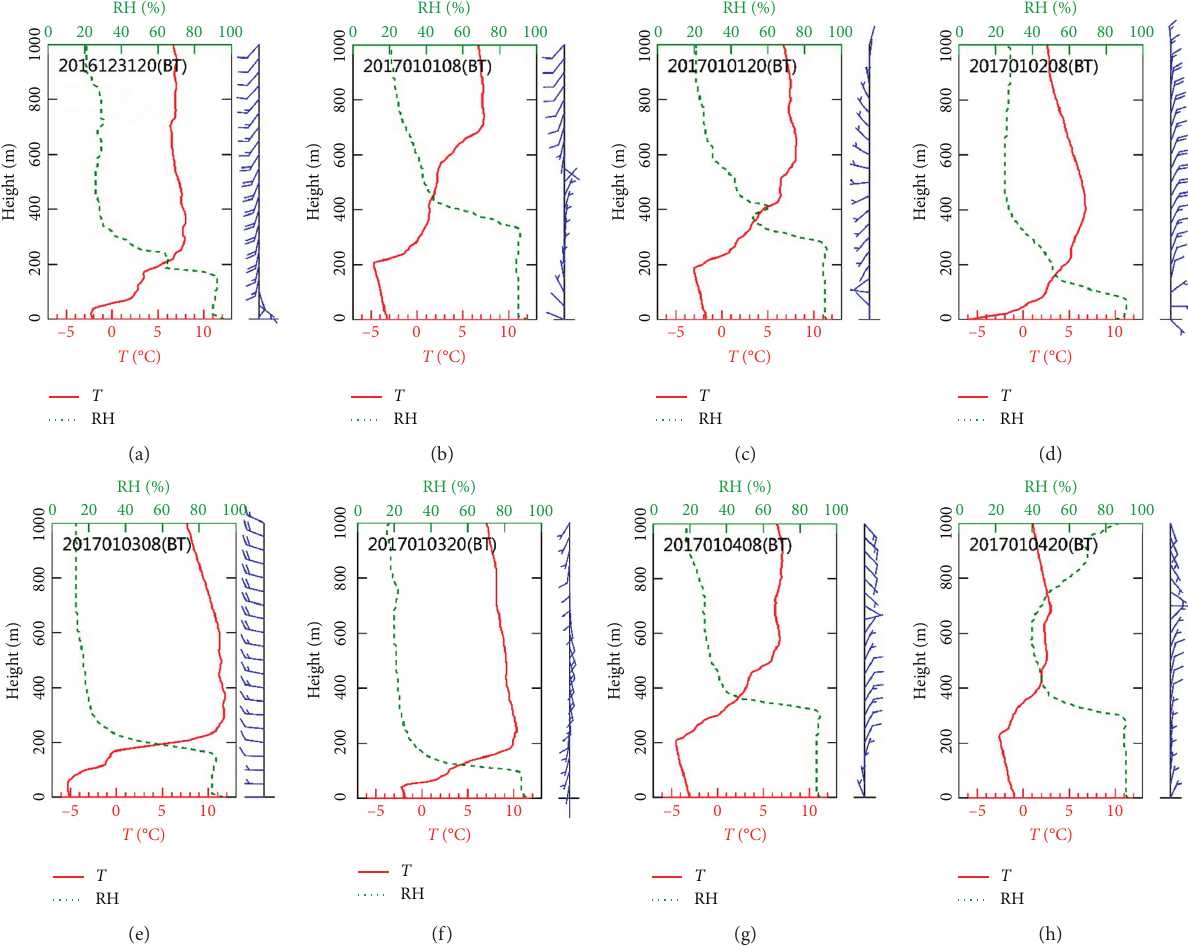
Figure 7: Temperature ( T unit: ° C), relative humidity (RH, unit: %), and wind direction (unit: ° ) and wind speed (unit: m · s − 1 ) profile of Xingtai Station when fog event occurred. (a) 2016123120 (BT). (b) 2017010108 (BT). (c) 2017010120 (BT). (d) 2017010208 (BT).